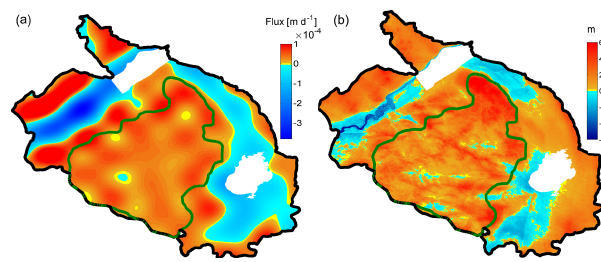
Figure 3. Comparison between simulated and inferred groundwa- ter discharge/recharge areas. (a) Simulated groundwater discharge (blue surfaces with negative groundwater fluxes) and recharge (red surfaces with positive groundwater fluxes) areas. (b) Inferred groundwater discharge (blue surfaces) and recharge (red surfaces) areas from the potentiometric surface generated using measure- ments from 1413 artesian wells. Areas where the presence of the artesian wells were sparse (i.e., at the Beaverhill Lake and in the vicinity of the North Saskatchewan River; see Fig. 1) were ex- tracted. The correlation coefficient between simulated groundwater fluxes at the land surface and the distance of potentiometric surface above and below land surface is 75% ( p